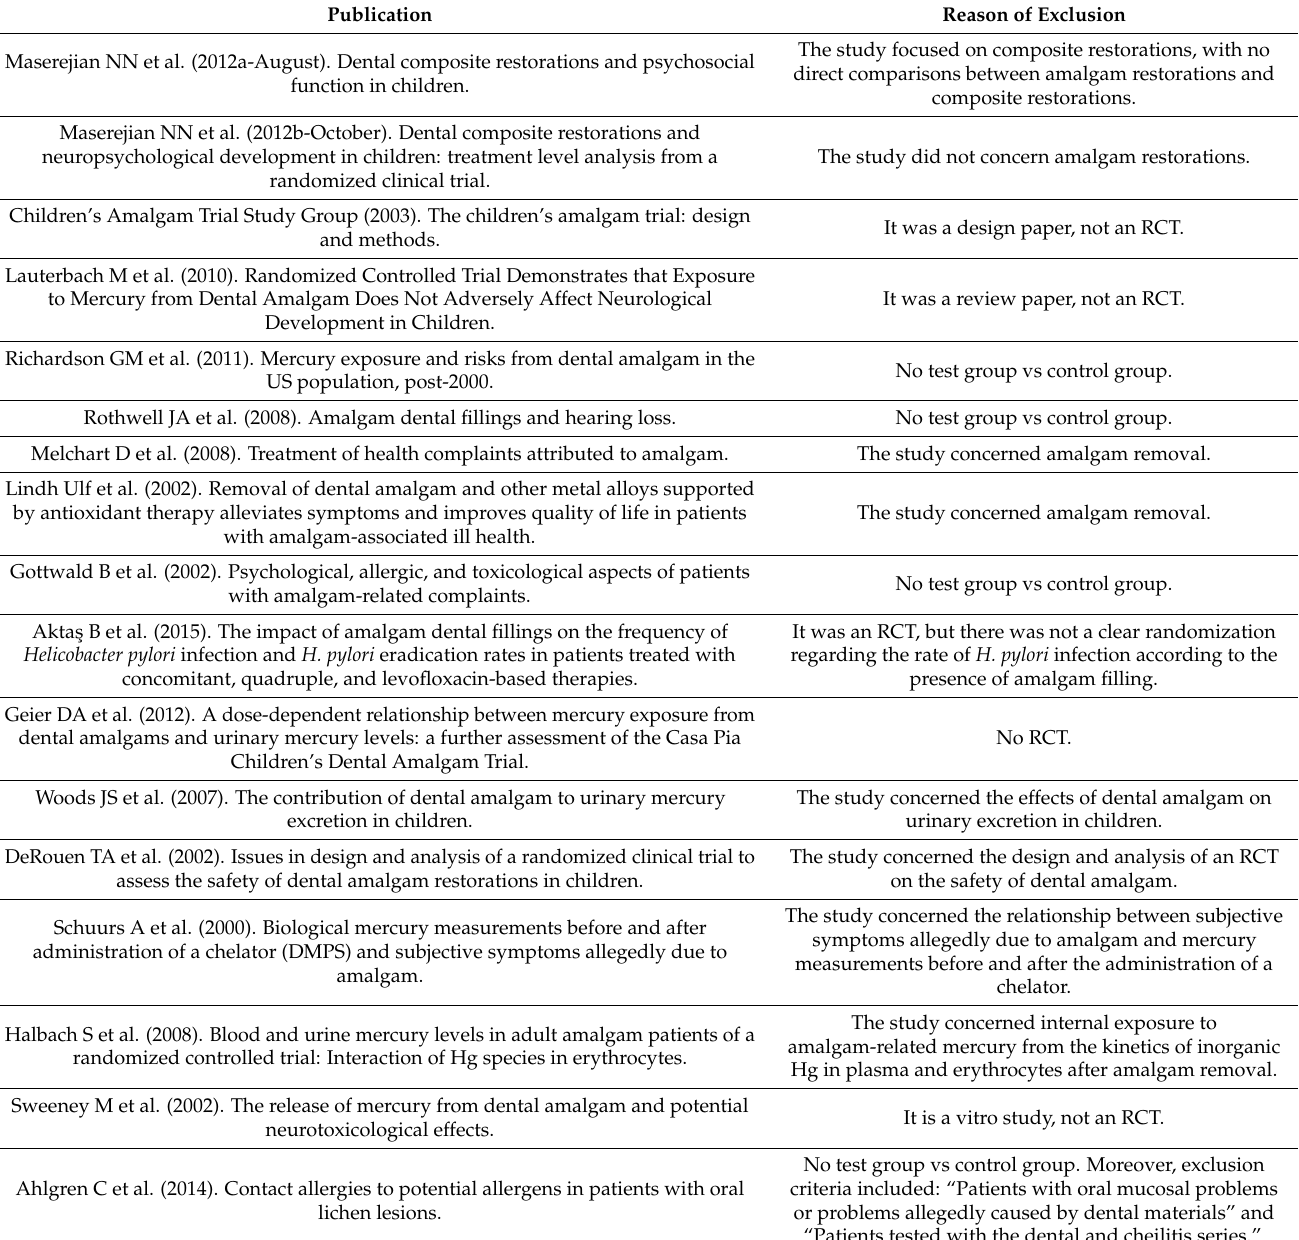
Table 3. Full-text articles excluded, with